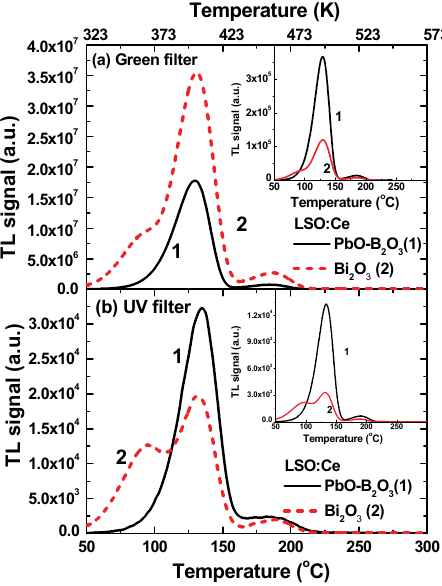
Figure 4. TL glow curves of LSO:Ce SCFs grown from PbO (1) and Bi 2 O 3 (2) based fluxes, registered using ( a ) “green” and ( b ) “UV” emission filters. Main graphs show TL glow curves measured after irradiation with alpha particles (3.9 × 10 7 cm − 2 ) and insets show TL glow curves after exposure to beta particles.